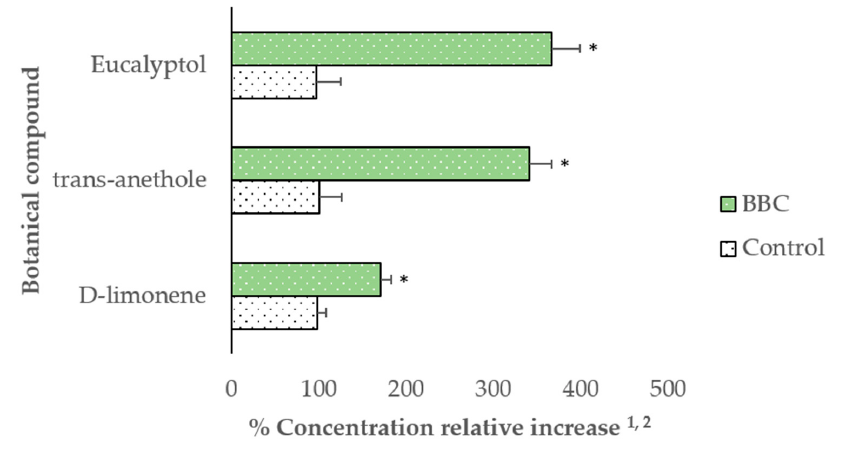
Figure 1. Relative concentration of botanical compounds in placental fluid of hyperprolific sows supplemented with dietary BBC. 1 Data are means of 12 sows per treatment ( n = 12); 2 Difference in abundance/retention time of the BBC relative to assigned reference values (100%) in Control sows. Treatments: Control: unsupplemented diet; BBC: Control plus blend of botanical compounds. (*) Indicate significant differences ( p < 0.05) using t -test.